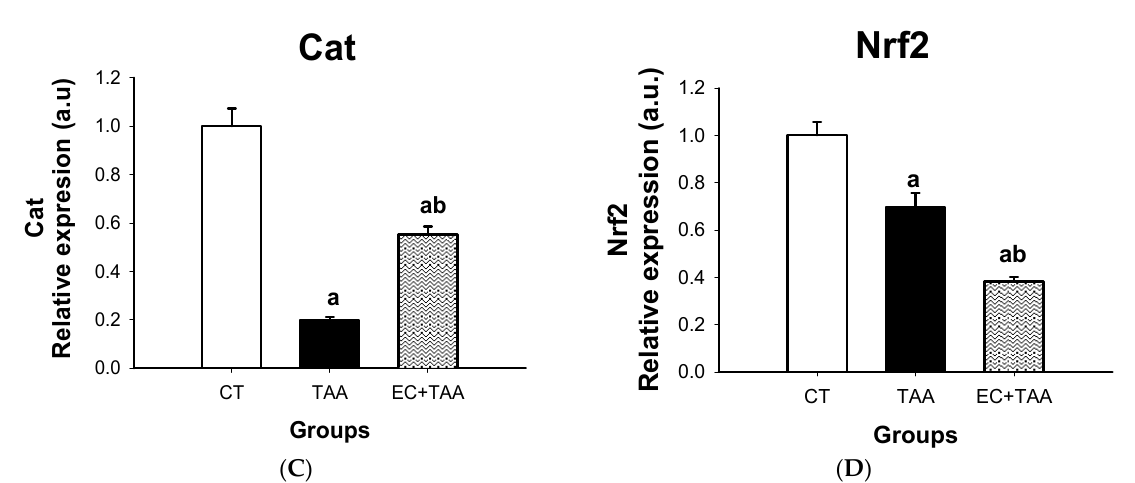
Figure 6. Effect of EC on ( A ) MnSOD, ( B ) CuZnSOD, ( C ) Cat, and ( D ) Nrf2 expression in homogenated liver of rats intoxicated with a sublethal dose of thioacetamide (TAA). The results are expressed in relative expression, arbitrary units (a.u.). Bars indicate the mean value with the SE of two determinations (n = 8). The differences compared with the vehicle are expressed as “ a ”; while the differences due to TAA are expressed as “ b ”, p ≤ 0.05.